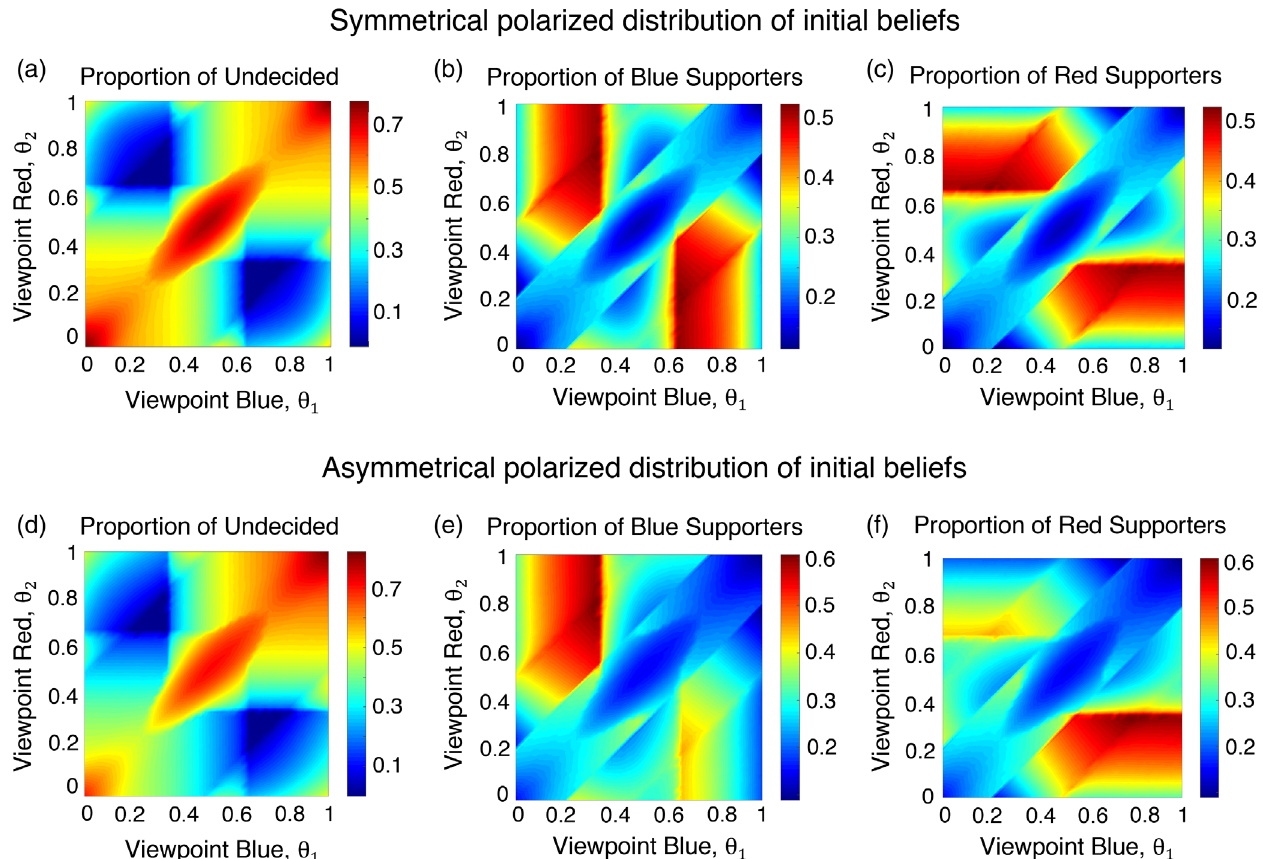
FIG. 12. Competing campaign ideologies under polarized initial beliefs. The initial condition of individual beliefs is relaxed from a uniform distribution to a symmetrical bimodal distribution (a) – (c) and an asymmetrical bimodal distribution (d) – (f). Results largely resemble findings from the original model: Candidates collectively capture more voters and minimize undecideds by having opposing views. Simulation results are averaged over 30 independent runs. Parameters: All simulations begin from an ER graph with N ¼ 10 4